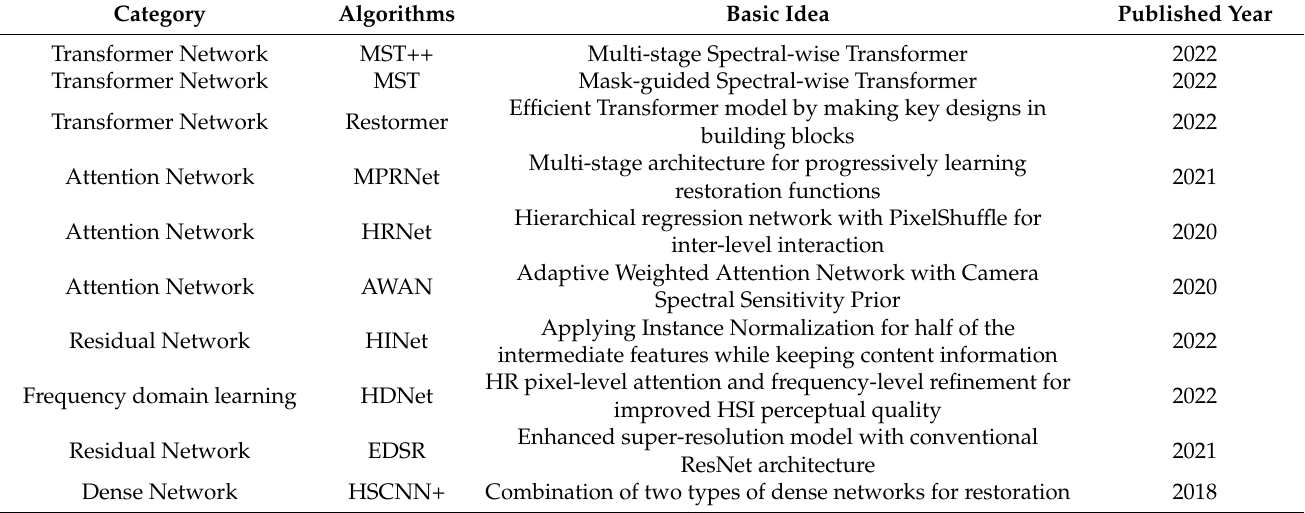
Table 1. An overview of the state-of-the-art methods used for comparing the efficiency of proposed